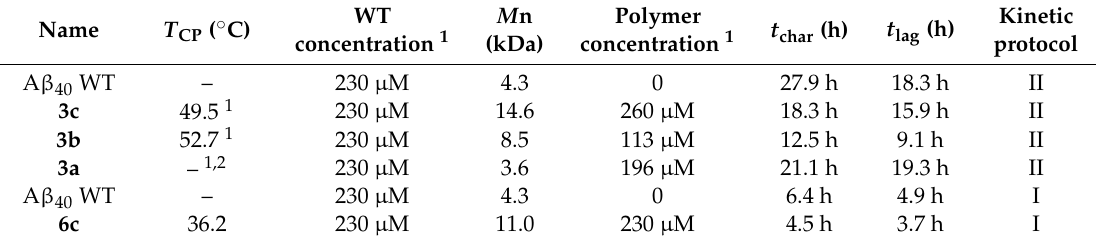
Table 2. Measured data for the fibrillation kinetics of the A β 40 fibrillation in the presence of the polymers 3a , 3b , 3c (Fluorescence Protocol II) and 6c (Fluorescence Protocol I, see Methods) at 37 ˝ C. The characteristic time and lag time vary between the different protocols, as shaking times varied between the two protocols. Shaking increases the probability of molecular contacts, thus enhancing